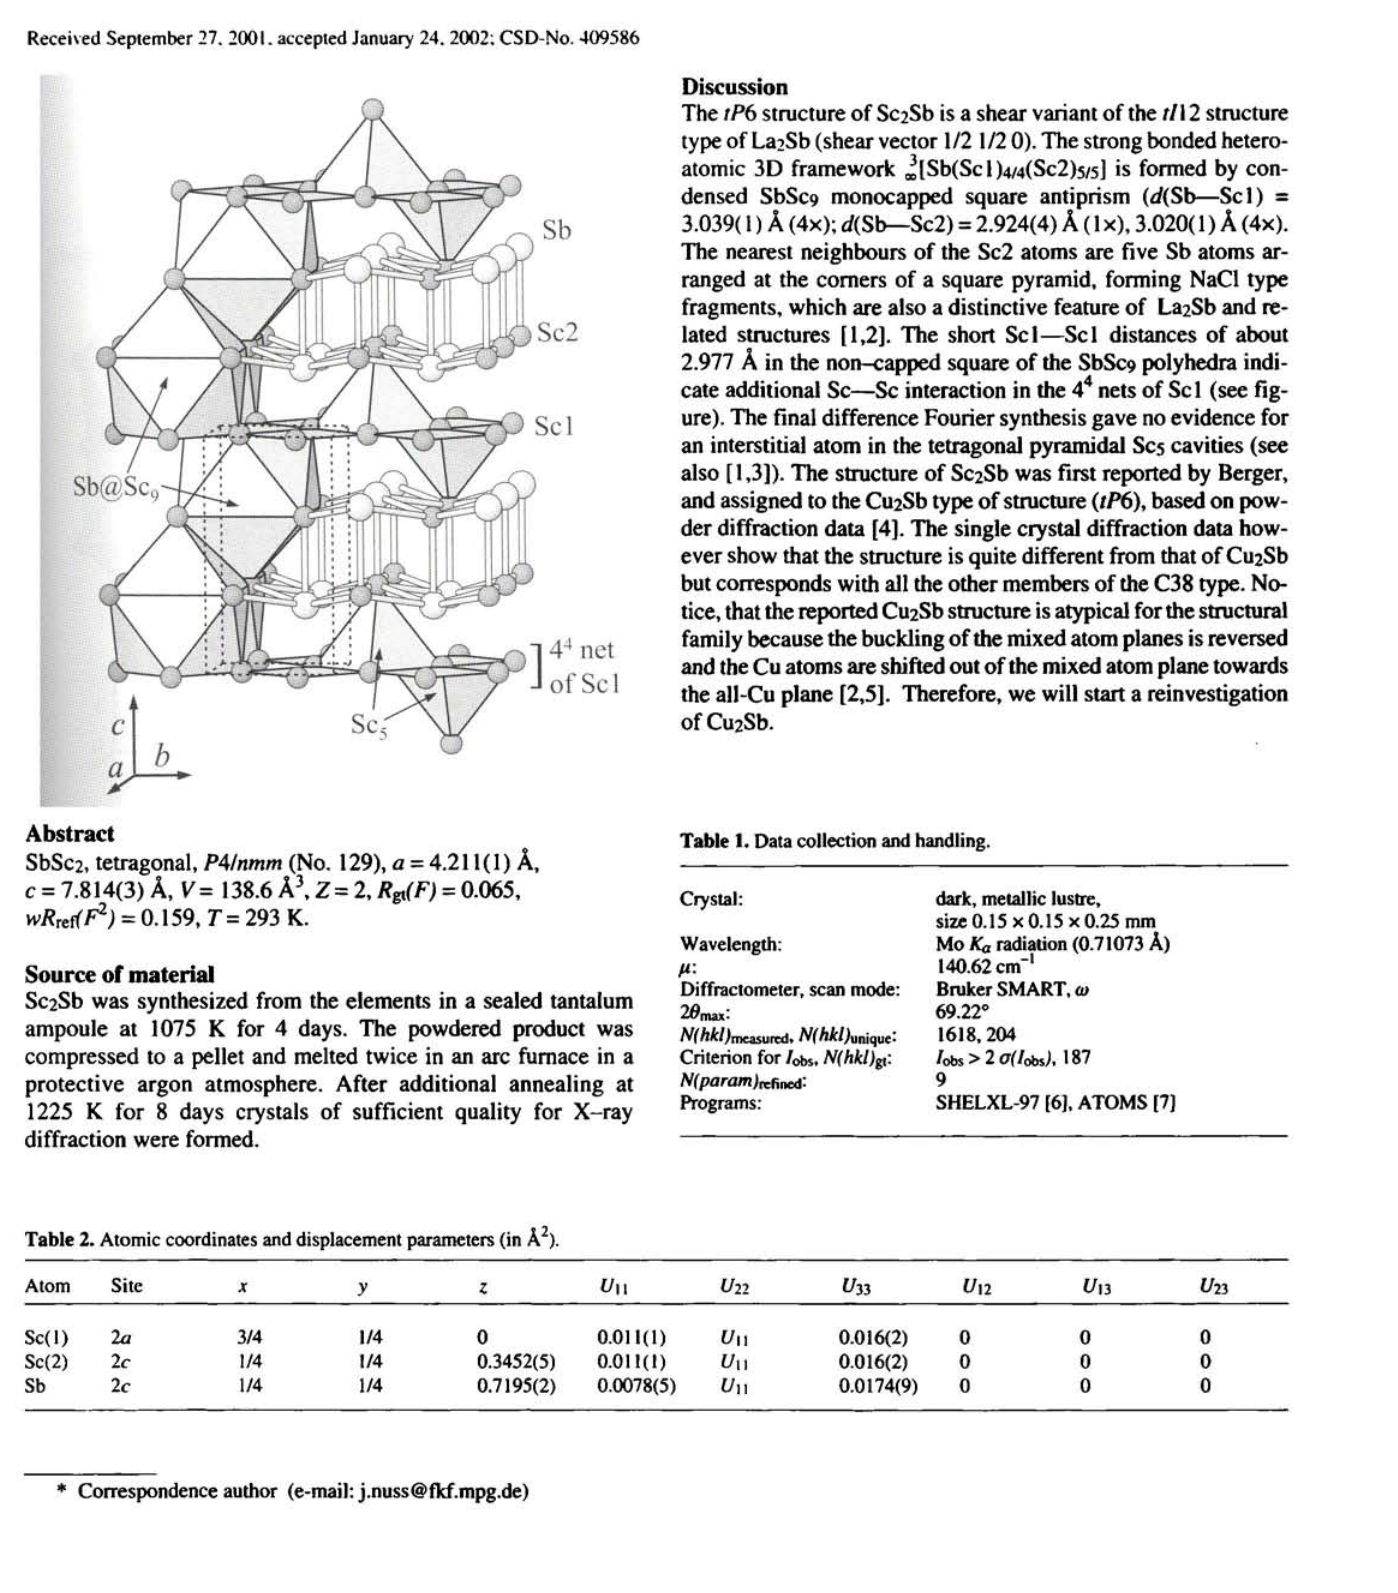
Table 2. Atomic coordinates and displacement parameters (in À 2